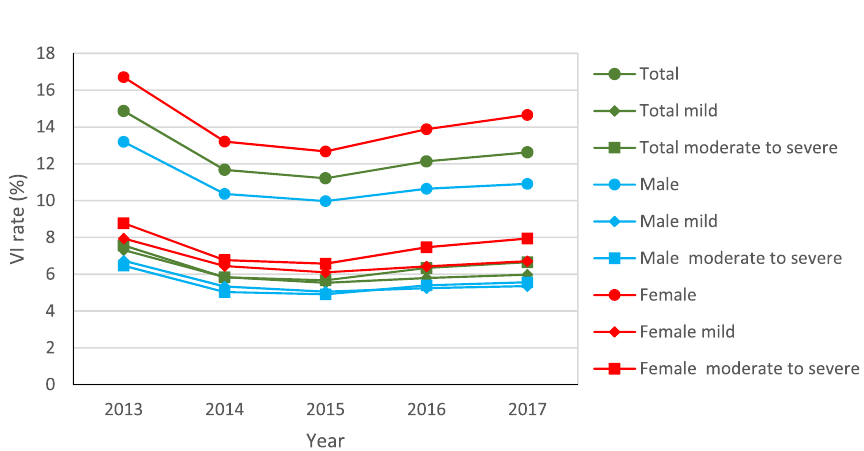
Figure 1. Trends in overall and gender-specific visual impairment (VI) among children in Shandong province from 2013 to